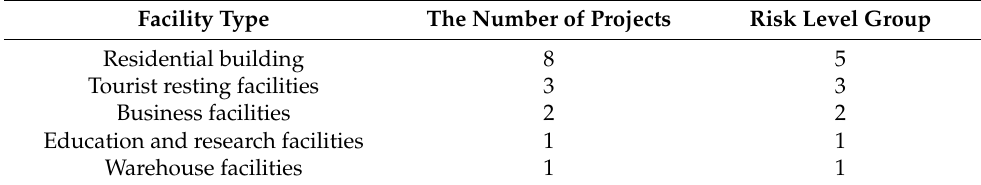
Table 8. Construction project carried out by ‘L’ contractor in 2017.